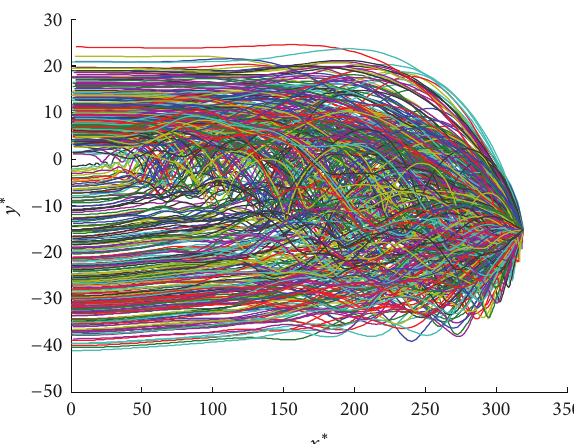
Figure 5: Lagrangian trajectories passing through a point at various time instants.